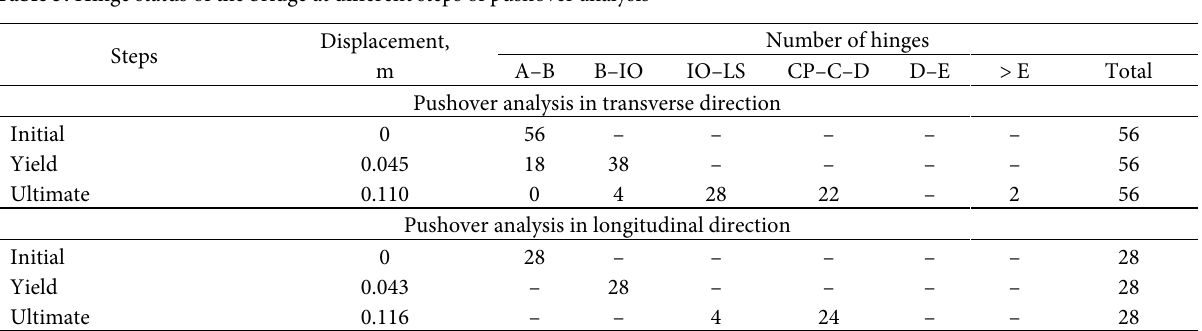
Table 3. Hinge status of the bridge at different steps of pushover analysis Steps